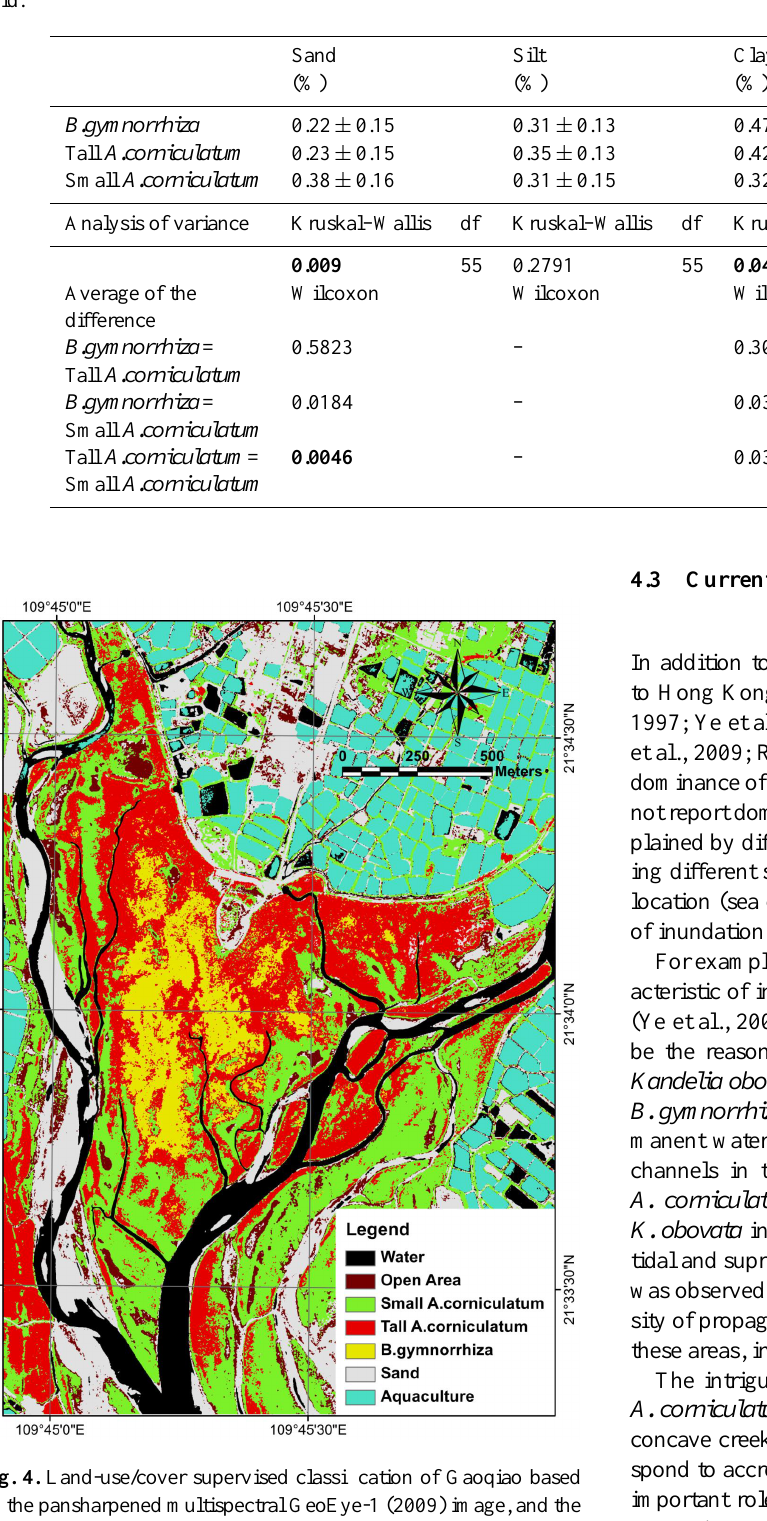
Table 4. Sediment and salinity characteristics at three mangrove classes in ZMNNR, Gaoqiao, China. The average and standard deviation values as well as their significance level are indicated ( α = 0 . 05 with Bonferroni correction for multiple test=0.017). Significant results are bold.